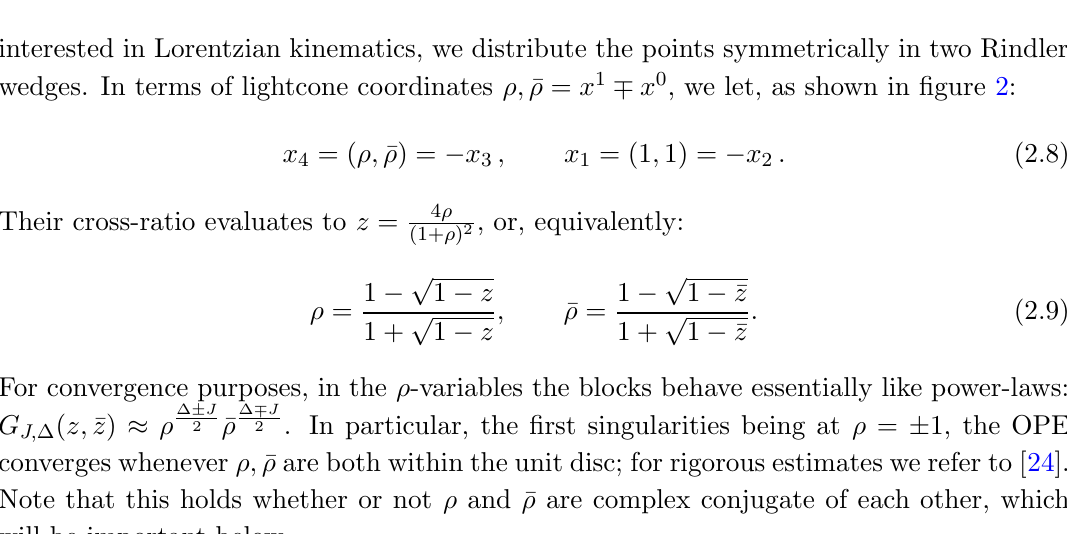
Figure 2 . (a) Four points in Lorentzian signature, with time running upward. The pairs x 4 (cid:0) x 1 and x 2 (cid:0) x 3 are timelike separated for (cid:22) (cid:26) > 1. (b) Corresponding con(cid:12)guration of cross-ratios (cid:26) and (cid:22) (cid:26)